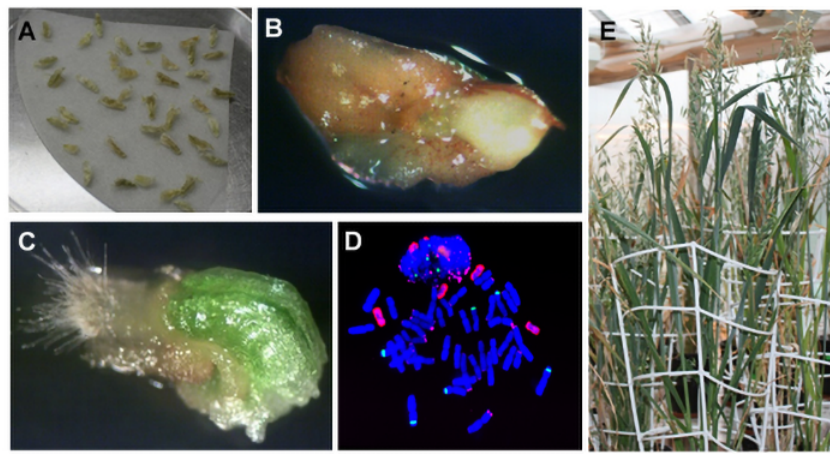
Figure 8 Oat ( Avena sativa L.) doubled haploids (DH) production by distant crossing with maize ( Zea mays var. saccharata ). ( A ) Caryopses aer 100 mg L − 1 2,4-D treatment. ( B ) Haploid embryo isolated from ovary. ( C ) Germinated haploid embryo on 190-2 medium. ( D ) Oat chromosomes with tetrasomic addition of maize